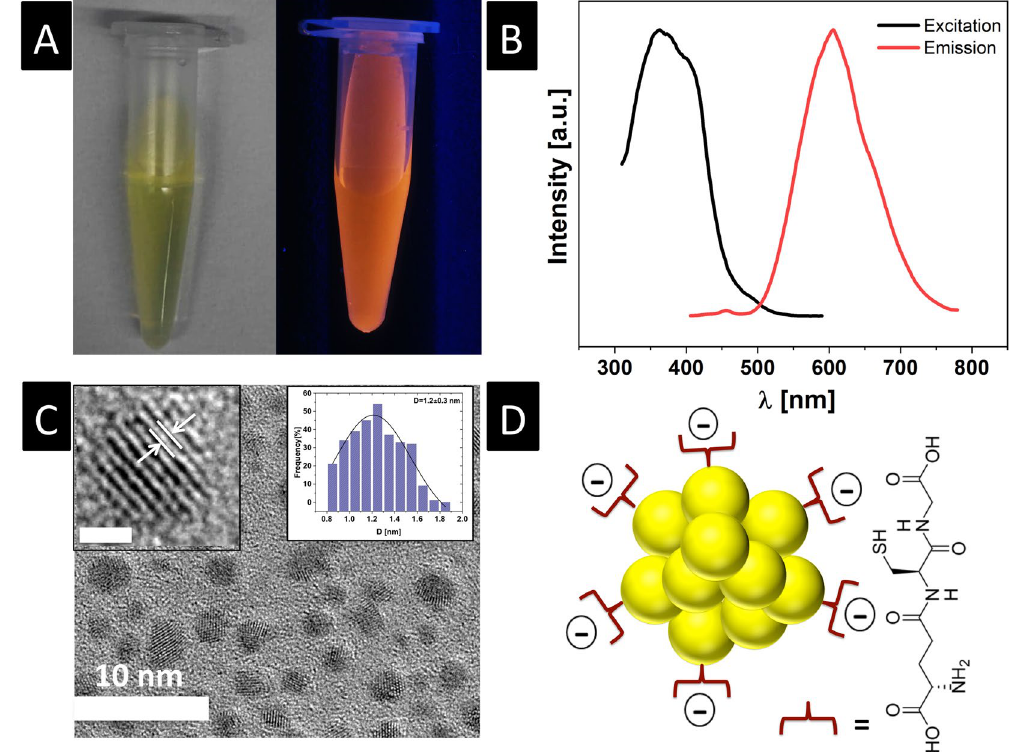
Figure 1. ( A ) Digital photograph of aqueous GSH-AuNCs suspension under daylight (left) and under long- wavelength UV lamp irradiation (365 nm) (right). ( B ) Excitation and emission spectra of GSH-AuNCs in water, as labeled. ( C ) TEM image of GSH-AuNCs (scale bar = 10 nm) with a left insert showing a high-resolution TEM image of the lattice planes separated by 0.24 nm (scale bar = 1 nm) and a right insert showing particle size histogram. ( D ) Sketch shows the gold core and glutathione shell of GSH-AuNCs as well as the chemical structure of the